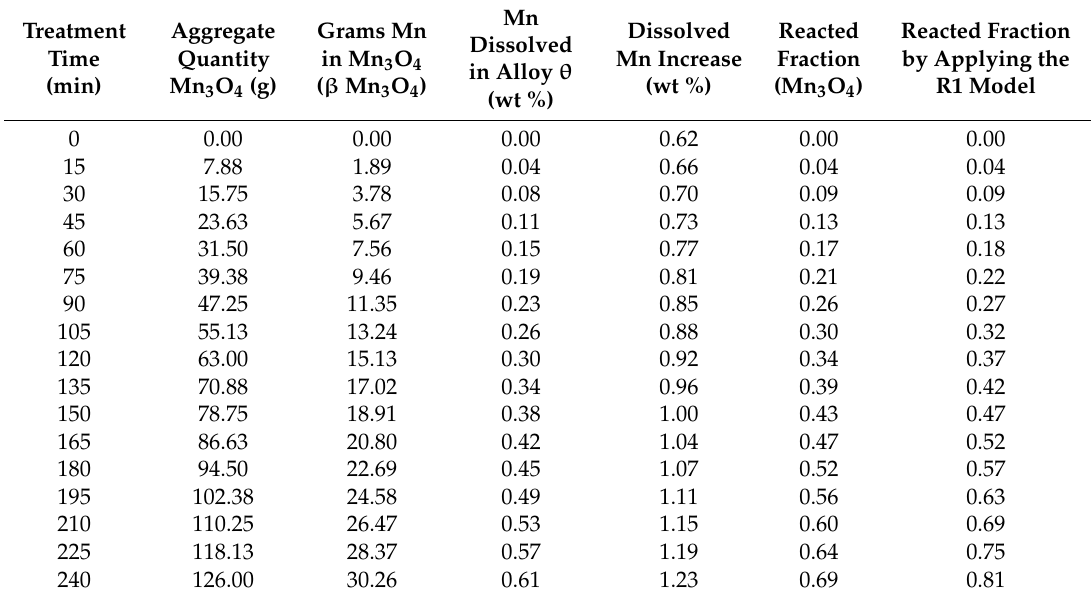
Table 4. Data calculated for the simulation of the quantities of Mn that would provide Mn 3 O 4 for each addition made according to the time of treatment.